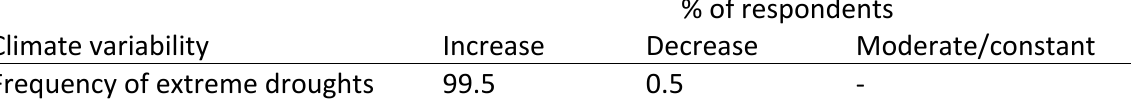
Percentage Distribution of Farmers by their Opinions on Climate Variability/ Change over the Previous 20 Years (2000 – 2019) (N = 400) Climate variability Frequency of extreme droughts Frequency of rainfall